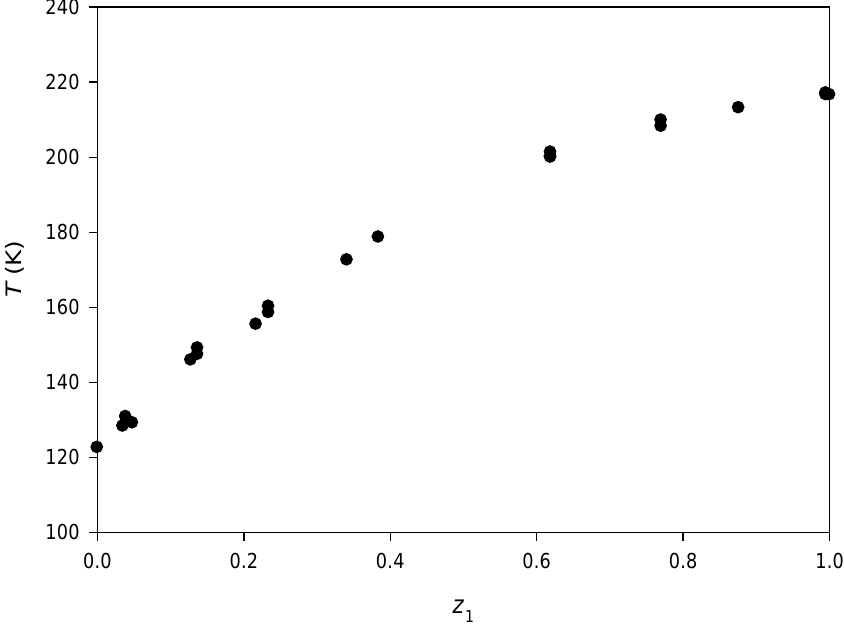
Figure 5. SLE for the R744 (1) + R1234yf (2) binary pair.